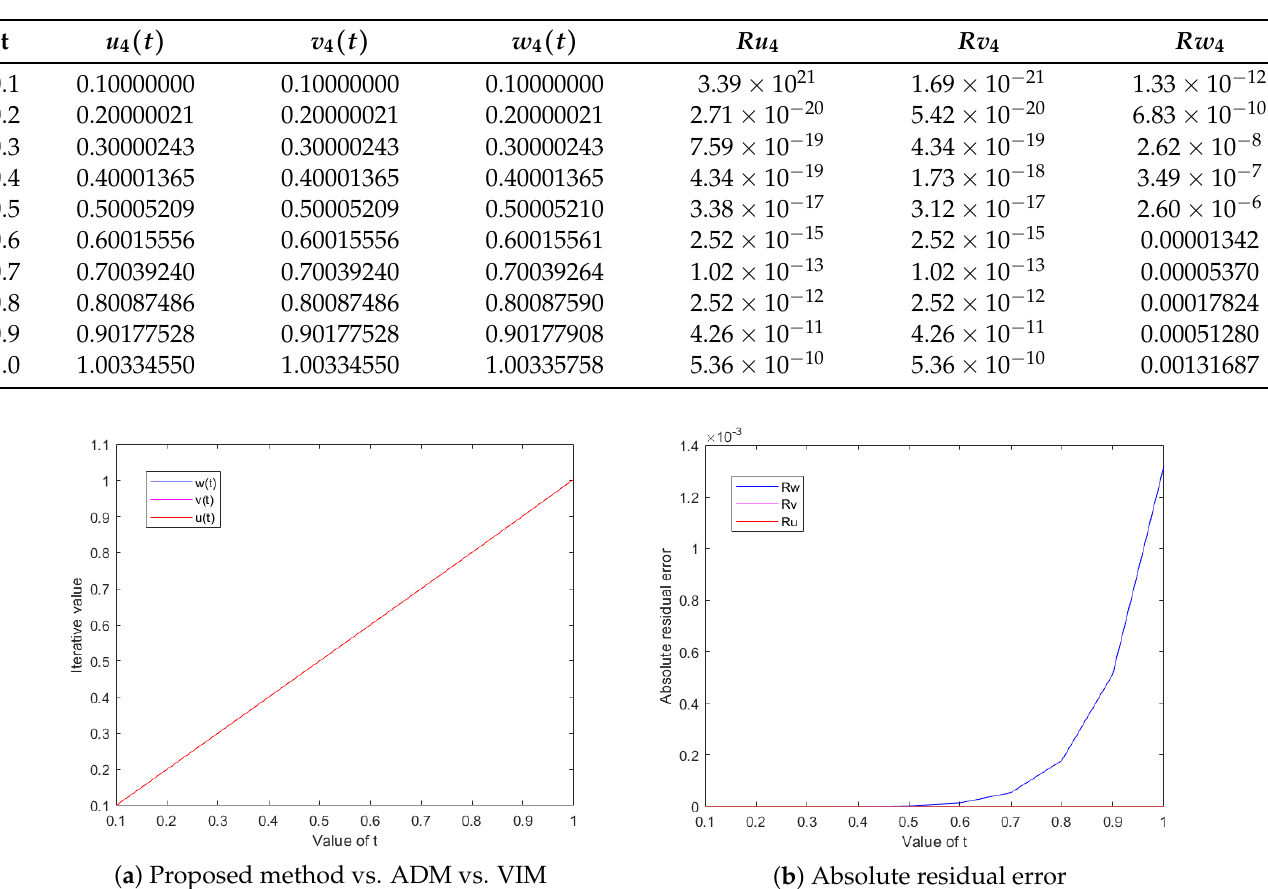
Table 1. Comparison of numerical results for Example 1.